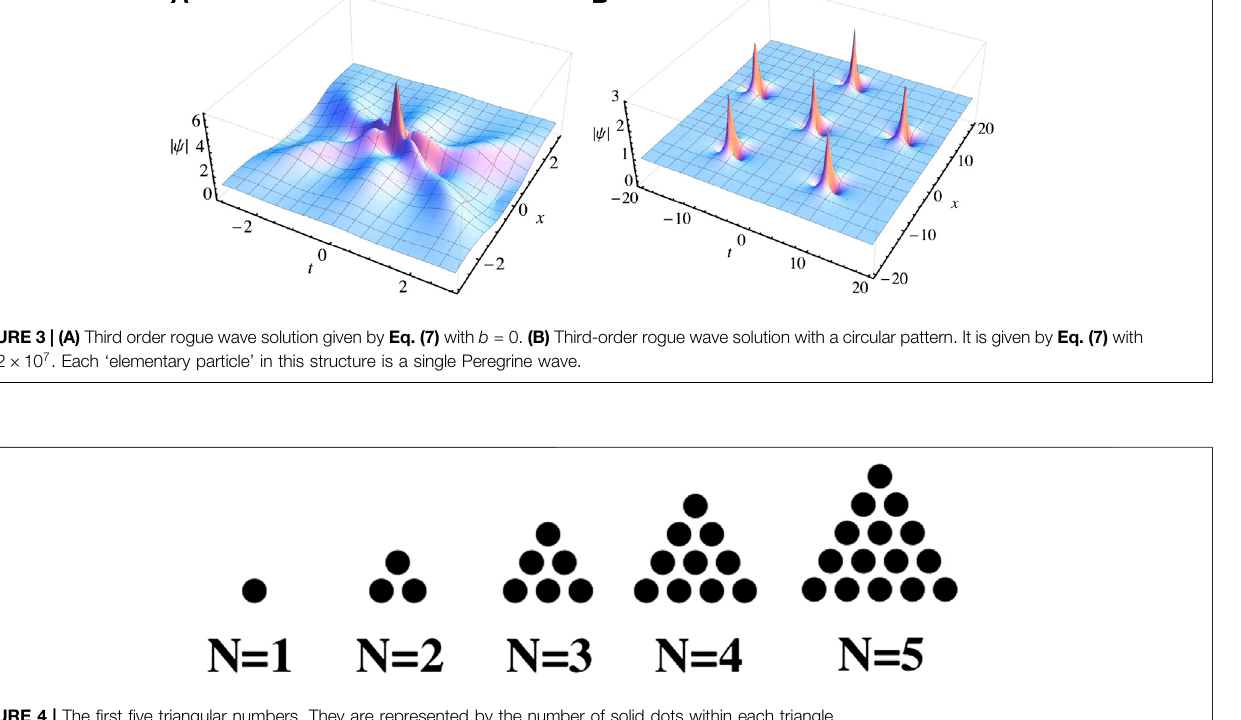
Frontiers in Physics |